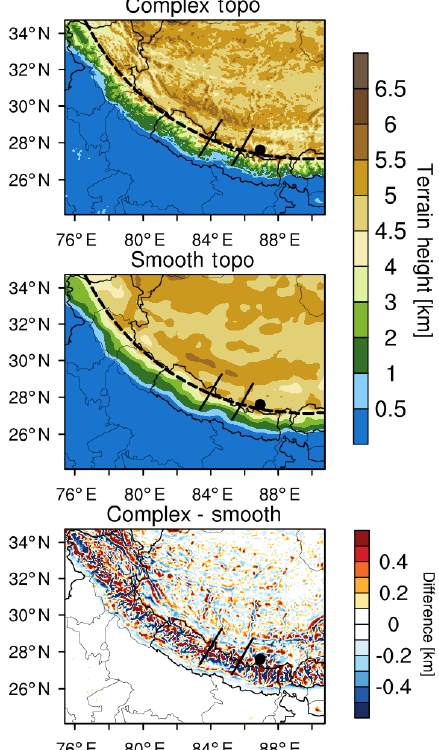
Figure 3. Spatial distributions of terrain height from the dataset at 4km resolution with the complex topography (complex topo) and smooth topography (smooth topo), which was bilinearly interpo- lated from the 20km resolution dataset. The dashed line and two solid lines represent the cross sections for analysis in the